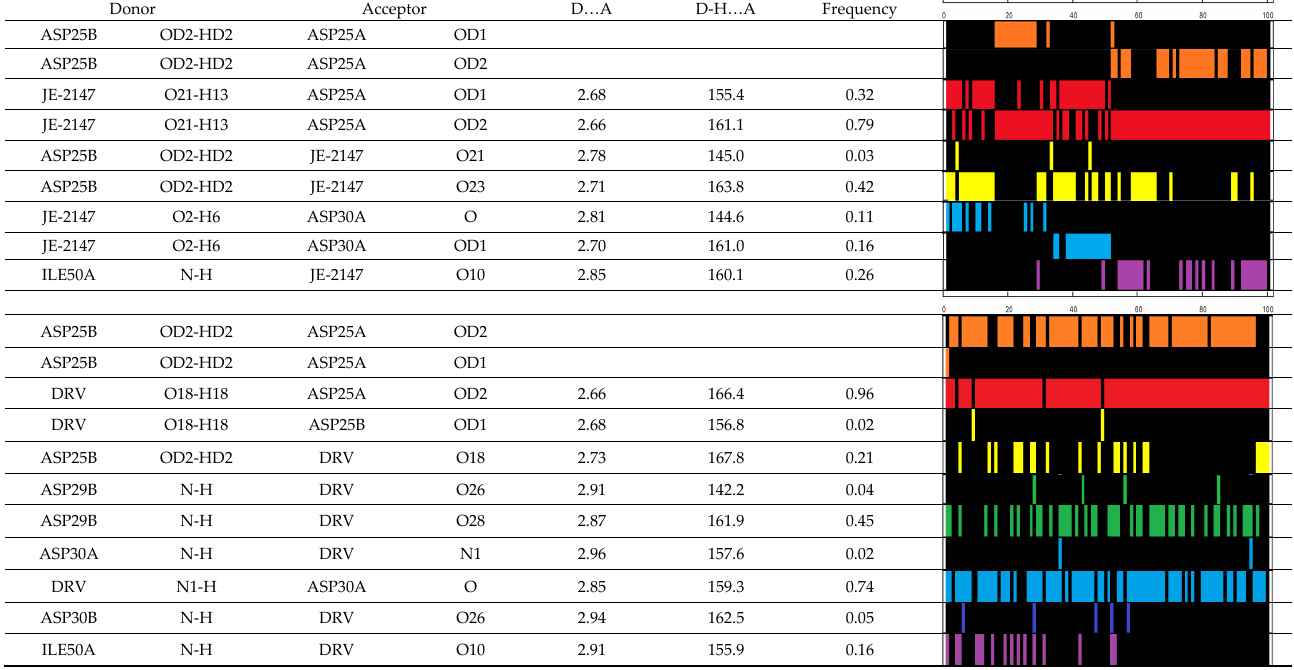
Figure 2. Hydrogen bonds identified in 100 snapshots of MD simulations for 1KZK ( top ) and 4DQB ( bottom ) structures, including average values of donor–acceptor distances (A) and hydrogen bond angles (°), along with the graphical representation of their occurrence (colored bars) in particular snapshot.